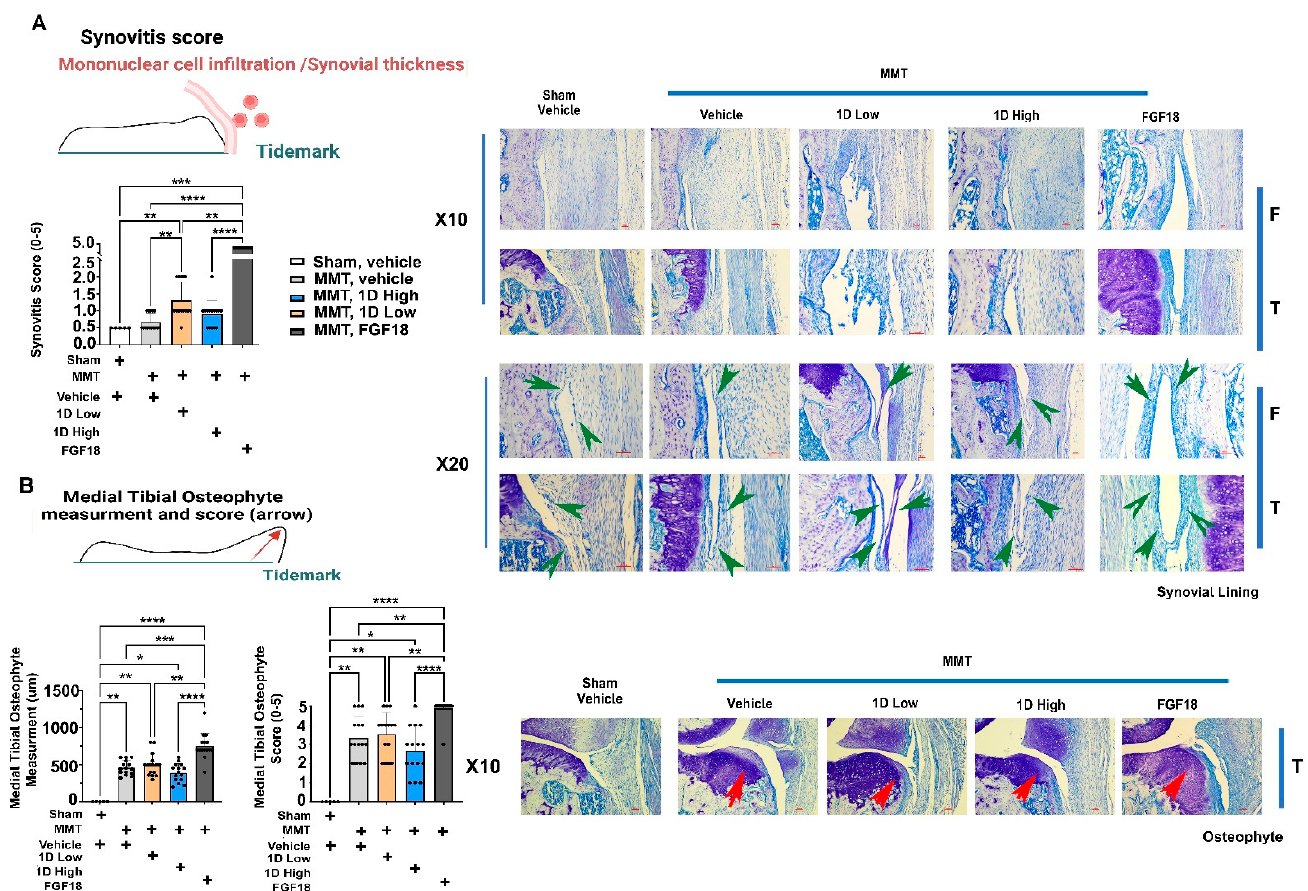
Figure 6. Histopathology for post-MMT Medial Tibial Synovitis and Osteophyte profiles. Synovitis scores were assessed according to the criteria in SD4, and displayed for all five groups ( A ) with a scheme and representative images (right panels), including green arrows pointing at the synovial lining. ( B ) Exhibits the measurement of osteophytes (left graph and upper illustration) and the score according to criteria in SD5 (right graph). The representative images are shown to the left of the graphs in panel B, including red arrows pointing at the measured osteophyte. Statistical significance between treatments and control was examined via the Kruskal–Wallis test with a Dunn’s post hoc analysis for scored (non-parametric) parameters, considering p < 0.05 (*) to be statistically signifi- cant. ** p < 0.01; *** p < 0.001; **** p < 0.0001. Sham, n = 5; MMT-Vehicle n = 15; MMT-1D, low dose 8 µg n = 15; MMT-1D, high dose 24 µg n = 15; and MMT-FGF18 3 µg n = 15.